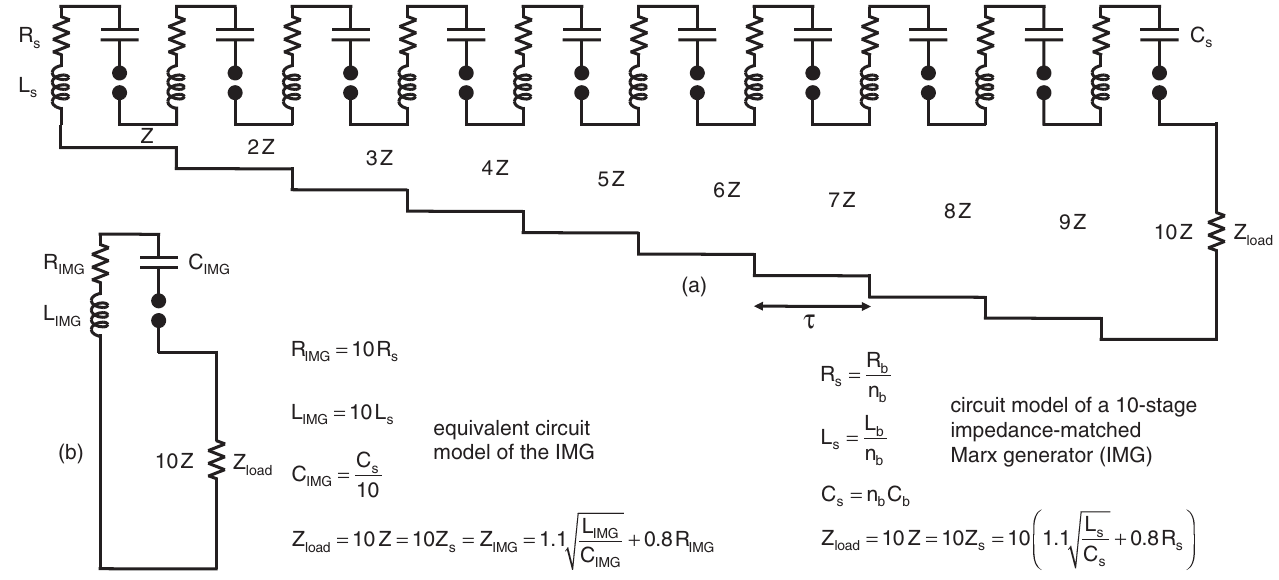
FIG. 5. (a) Circuit model of a ten-stage IMG. The IMG drives a ten-segment impedance-matched transmission line that in turn drives an impedance-matched load. The quantity R is the effective series resistance of a single IMG stage, L s inductance, C is the series stage capacitance, Z is the impedance of the first transmission-line segment, Z s the one-way electromagnetic transit time of a single segment, R is the effective series resistance of a single brick, n b bricks per stage, L is the effective series brick inductance, C is the series brick capacitance, and Z b b single stage. (b) When each stage is triggered at time τ after the stage immediately upstream is triggered, the circuit of (a) can be simplified as that given by (b). The quantity R is the effective series resistance of the IMG, L IMG inductance, C is the series IMG capacitance, and Z is the effective impedance of the ten-stage IMG. When circuit (b) is applicable IMG IMG and the values of Z and Z are as given by the figure, the IMG is impedance matched to the load; i.e., the peak electrical power load delivered by the IMG to the load is